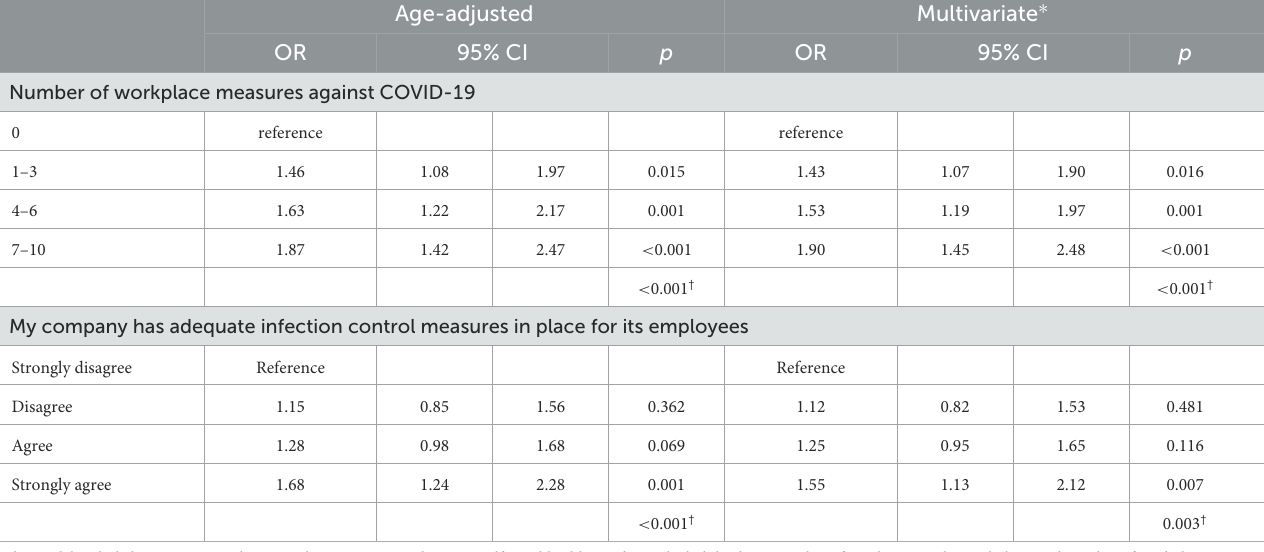
TABLE 2 Association between number of workplace measures against COVID-19 and activities in a new romantic relationship.